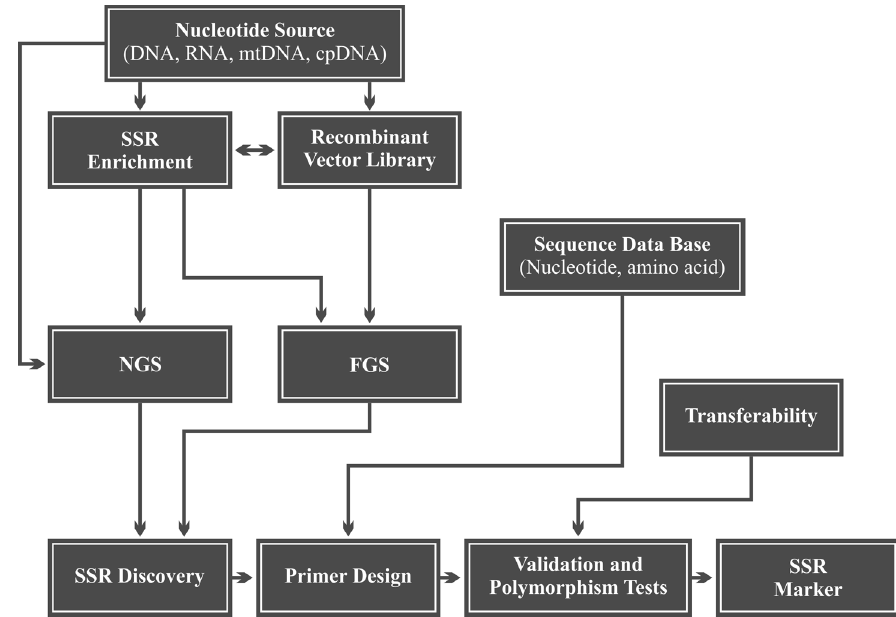
Figure 2 - Workflow steps of SSR marker